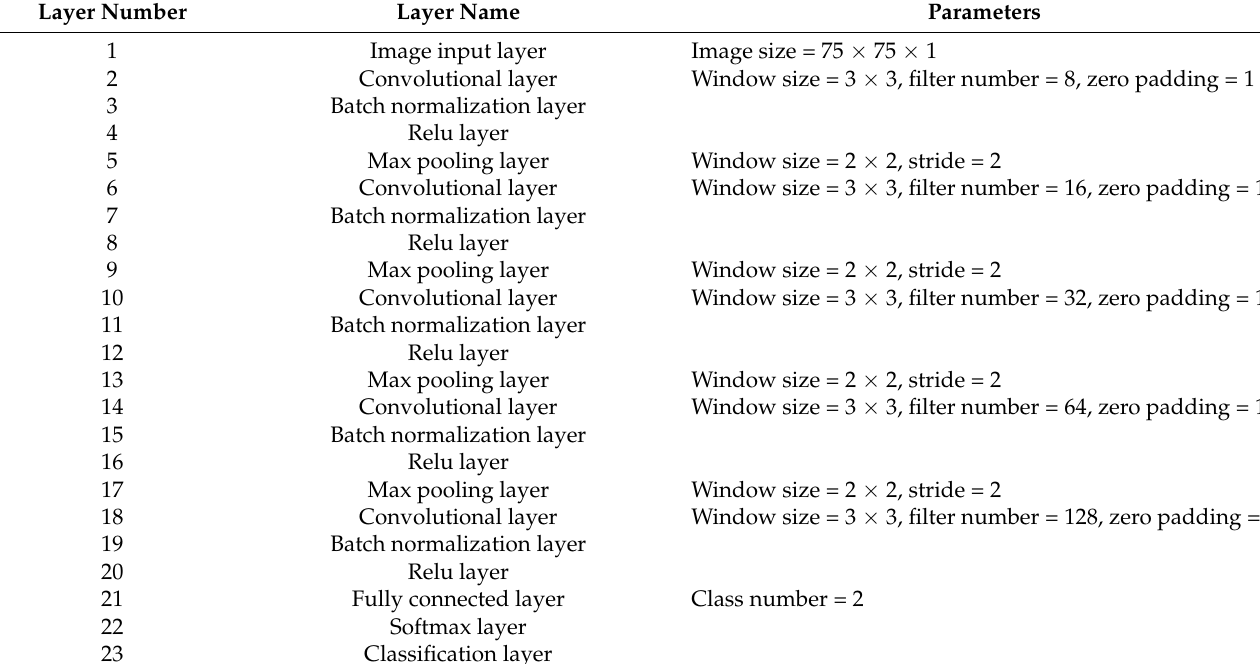
Table 1. Detailed layers of the face CNN.